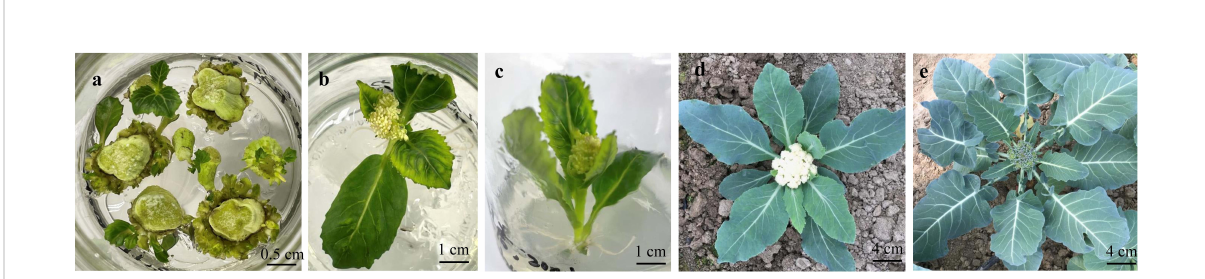
FIGURE 6 Transgenic plants regenerated from peduncle explants can directly grow curds and fl ower without going through low-temperature of vernalization. (A) resistant shoot screening of the peduncle explants from C60DH-3. (B, C) the regenerated plants of B65IL-5 (B) and C60DH-3 (C) budded in the tissue culture bottles. (D) transgenic plants of C90IL-9 were transplanted into soil, and the curd began to appear after 8-9 true leaves were grown. (E) transgenic plants of B100IL-9 were transplanted into soil and budded after growing 9-10 true